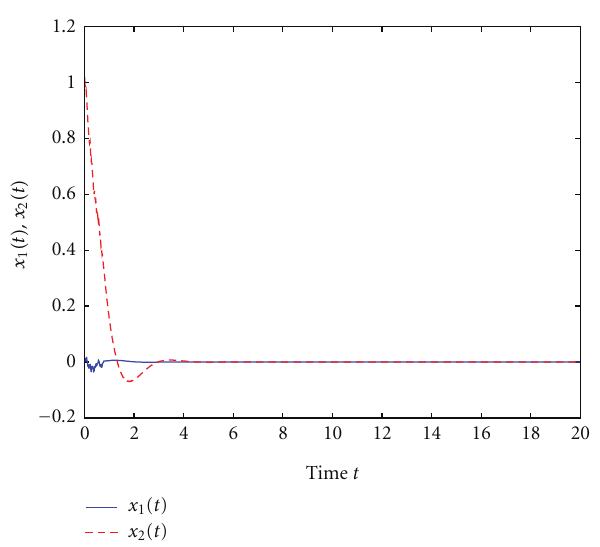
Figure 2: The trajectories of x 1 (cid:2) t (cid:3) and x 2 (cid:2) t (cid:3) of the system (cid:2) 4.5 (cid:3) with time-varying delay τ (cid:2) t (cid:3) (cid:9) 0 . 3 (cid:8) 0 . 5 | cos10 t |